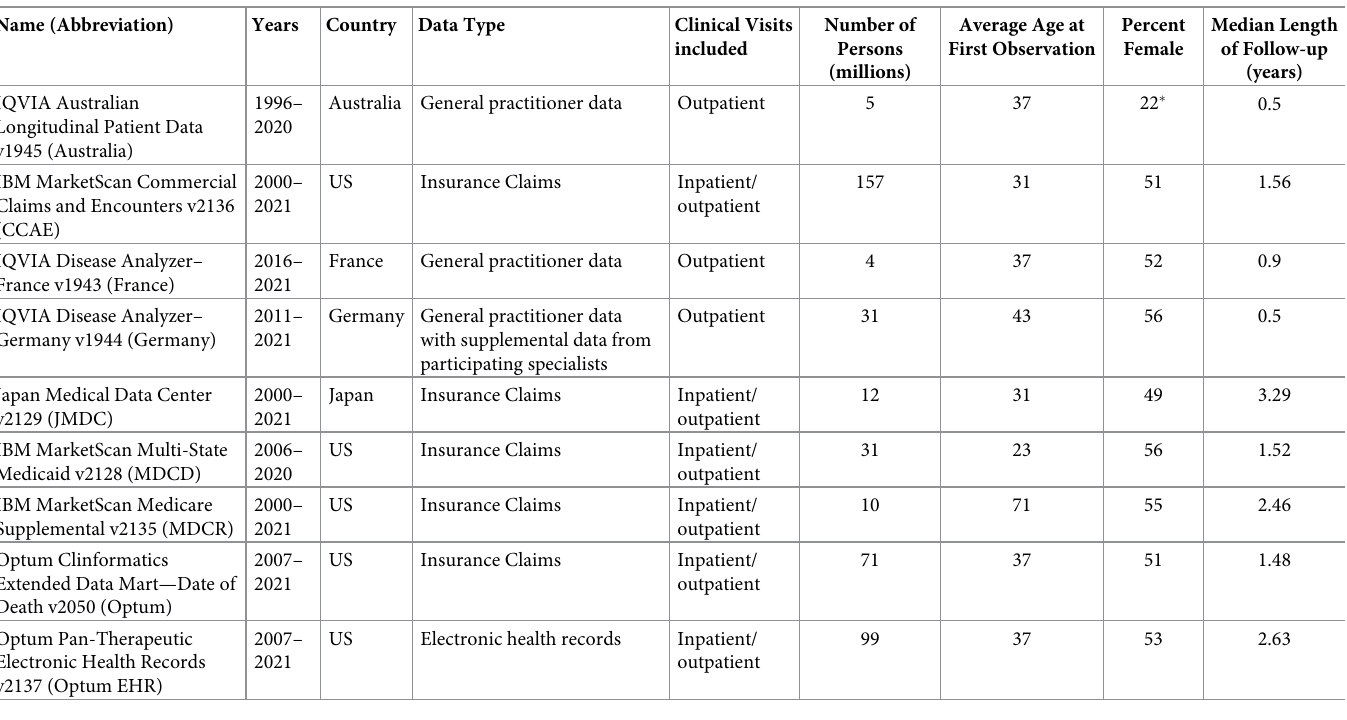
Table 2. Description of databases used in the